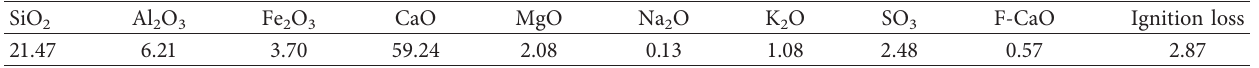
Table 1: Chemical composites of cement (%).